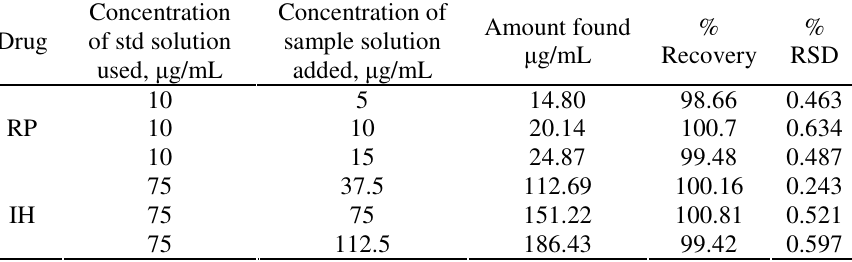
Table 1. Recovery studies of RP and IH (n=6)